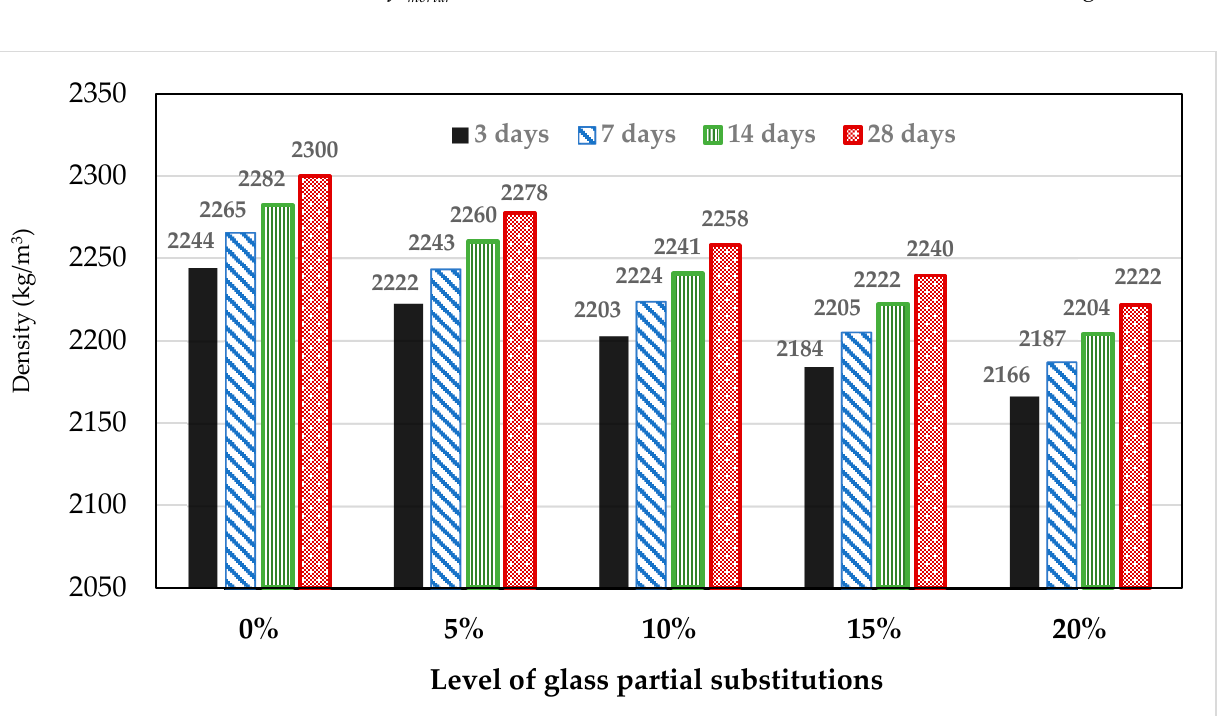
Figure 6. Effect of glass on the density of mortar.